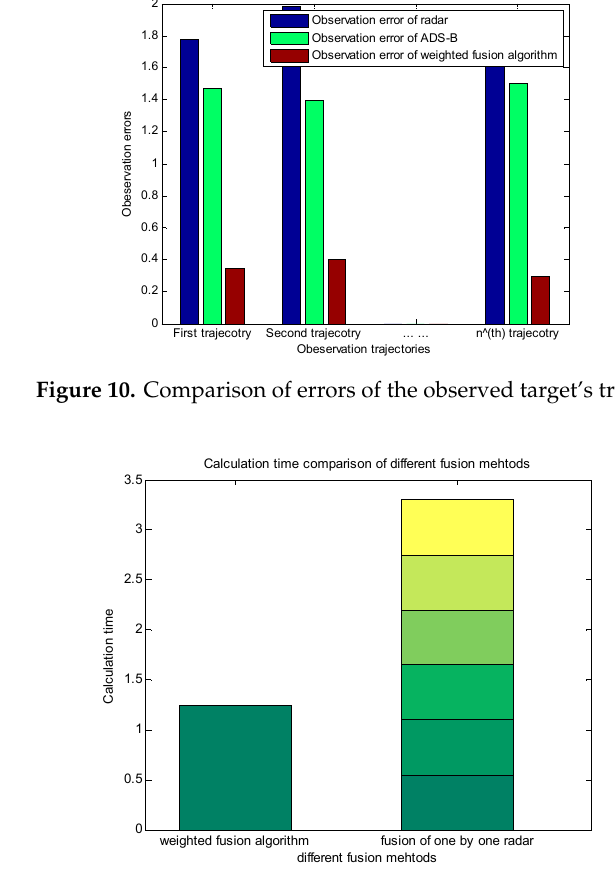
Figure 11. Comparison of calculation time with weighted fusion algorithm and general approach.